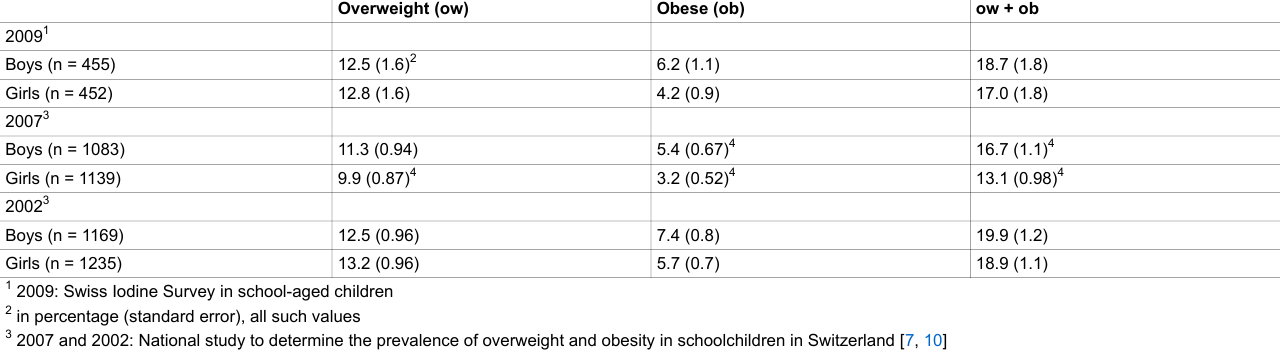
Table 1 Overweight and obesity prevalence in Swiss schoolchildren from three national studies conducted 2002, 2007 and